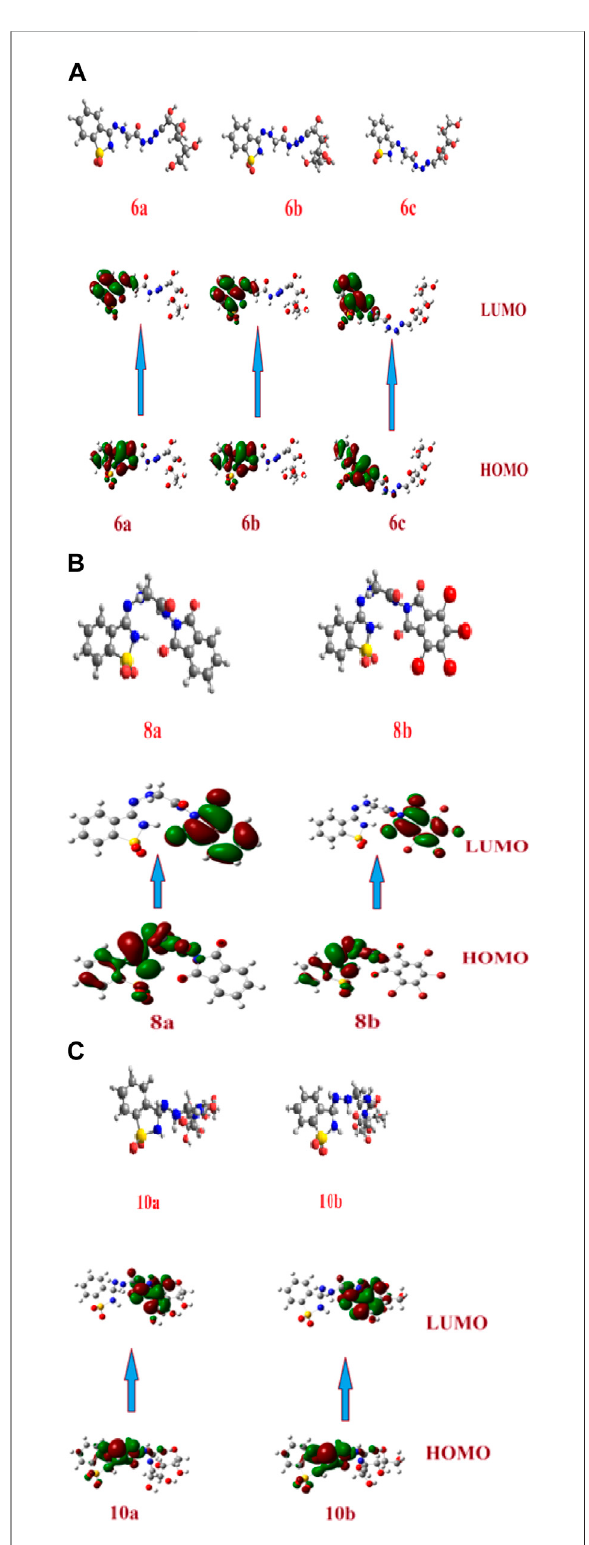
FIGURE 1 (A) Optimized geometrical structures of the prepared compounds(6a – c)andsurfaceplotscalculatedfromgroundstate isodensity for FMOs for the investigated compounds 6a – c . (B) .